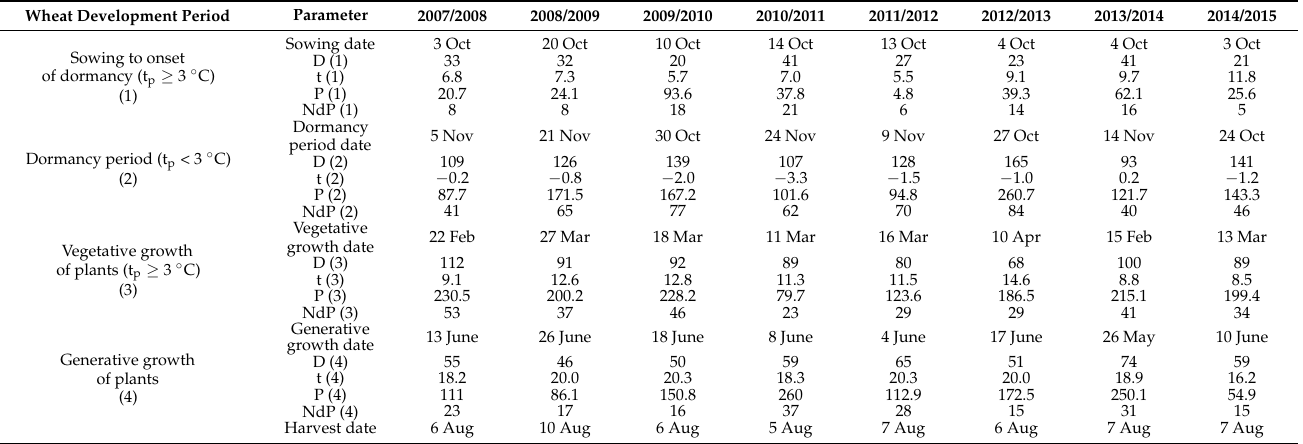
Table 1. Meteorological characteristics of the periods of development of winter wheat (1–4) at the Felin experimental